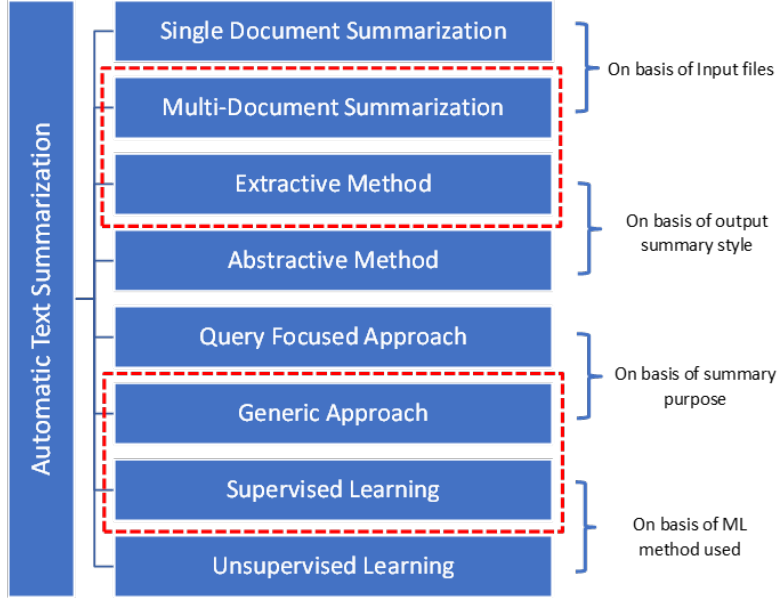
Figure 1. Hierarchical representation of categories of ATS.